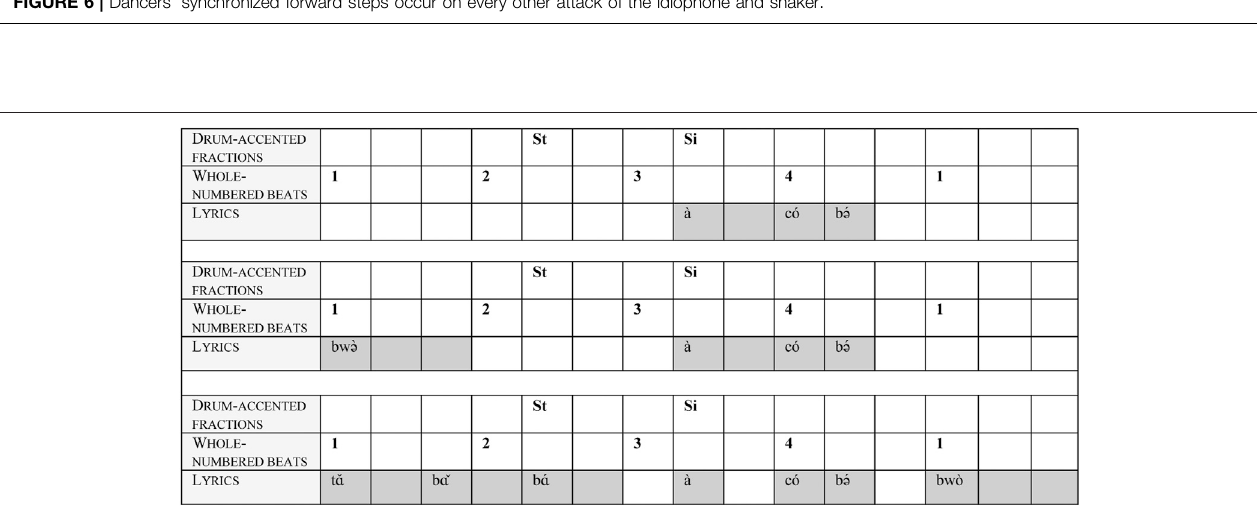
FIGURE 7 | Grid representation of master drummer ’ s opening lines and chorus. Numbers 1 – 4 represent whole-numbered beats on which the idiophone/shaker soundanddancersmove.Individualcellsrepresentbeatsonwhichthecomplexndu (cid:3) nla ̀ m/metallophonesounds.St/SirepresentbeatfractionsonwhichtheStandingor Sitting drum sounds. Gray fi lled cells indicate beats on which the voice is